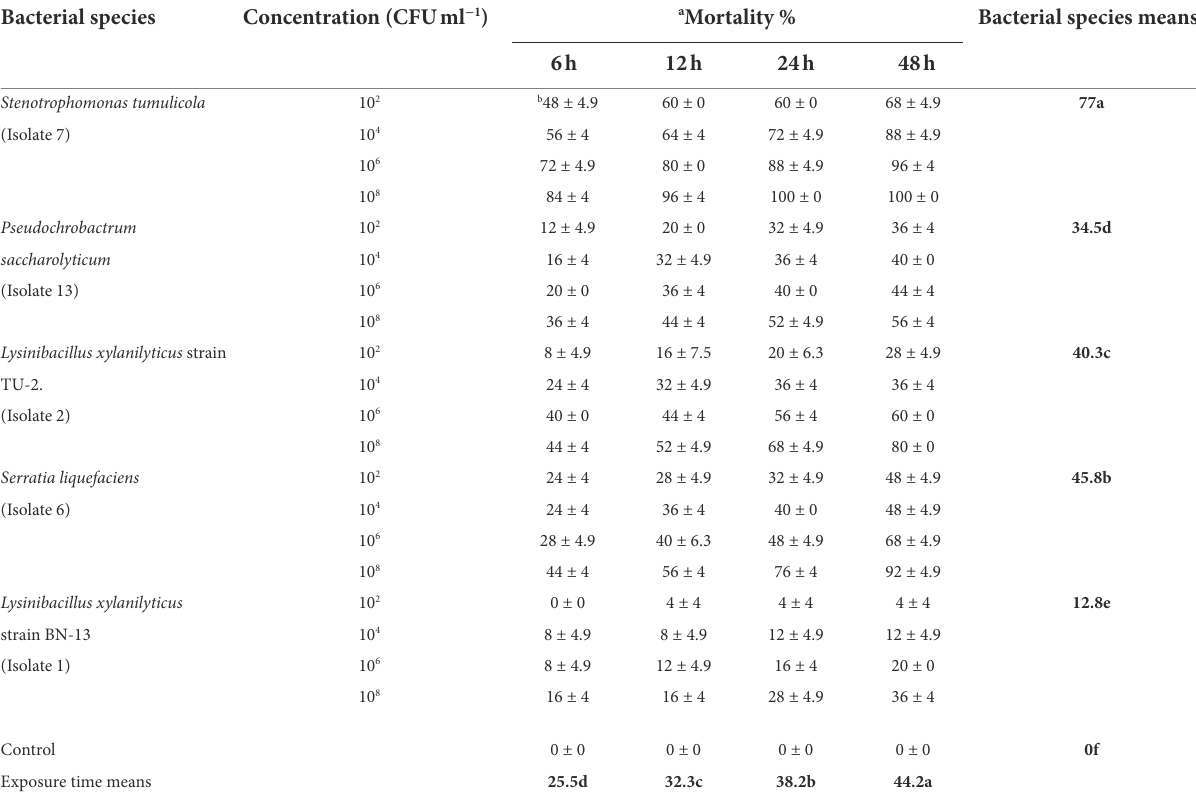
TABLE 2 Toxicity of five bacterial species cells against the grapevine aphid, Aphis illinoisensis under laboratory condition. Bacterial species